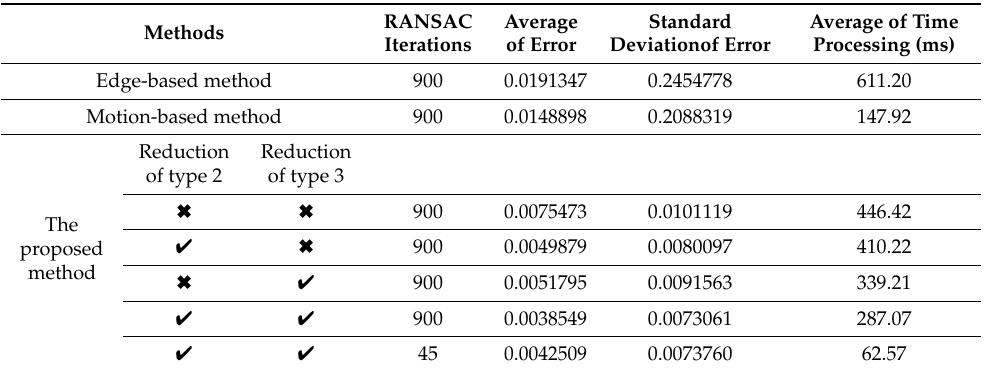
Table 1. Performance comparisons of the proposed, the motion-based [33] and the edge-based [29] methods in terms of the average distance between the detected and ground truth R-VPs, its standard deviation, and processing